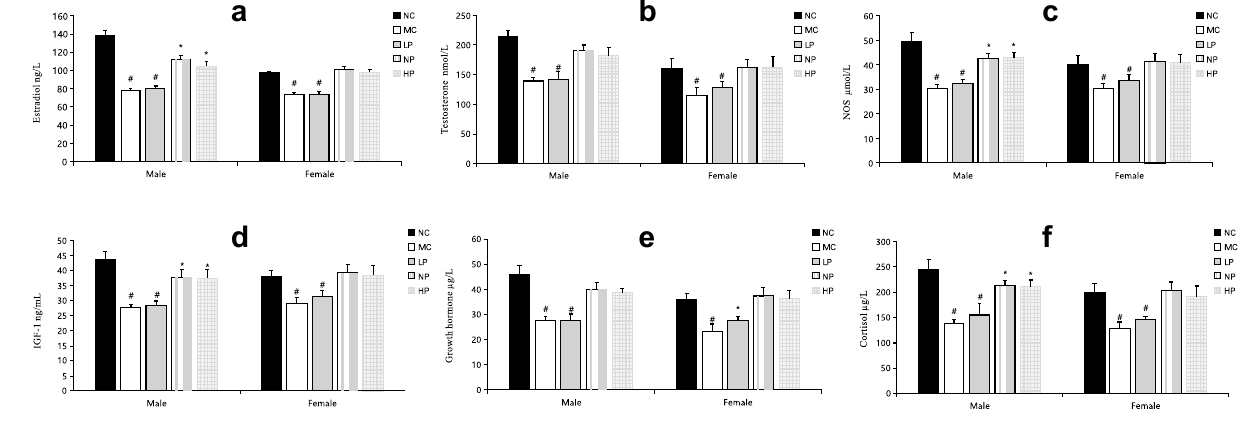
Figure 4. Concentration of hormones associated with the metabolism of skeletal muscle in the plasma of different groups. ( a ) Statistical analysis of estradiol. ( b ) Statistical analysis of testosterone. ( c ) Statistical analysis of NOS. ( d ) Statistical analysis of IGF-1. ( e ) Statistical analysis of growth hormone. ( f ) Statistical analysis of cortisol. Mean values of the same sex with different superscript symbols (#, *) were significantly different ( P < 0.05).